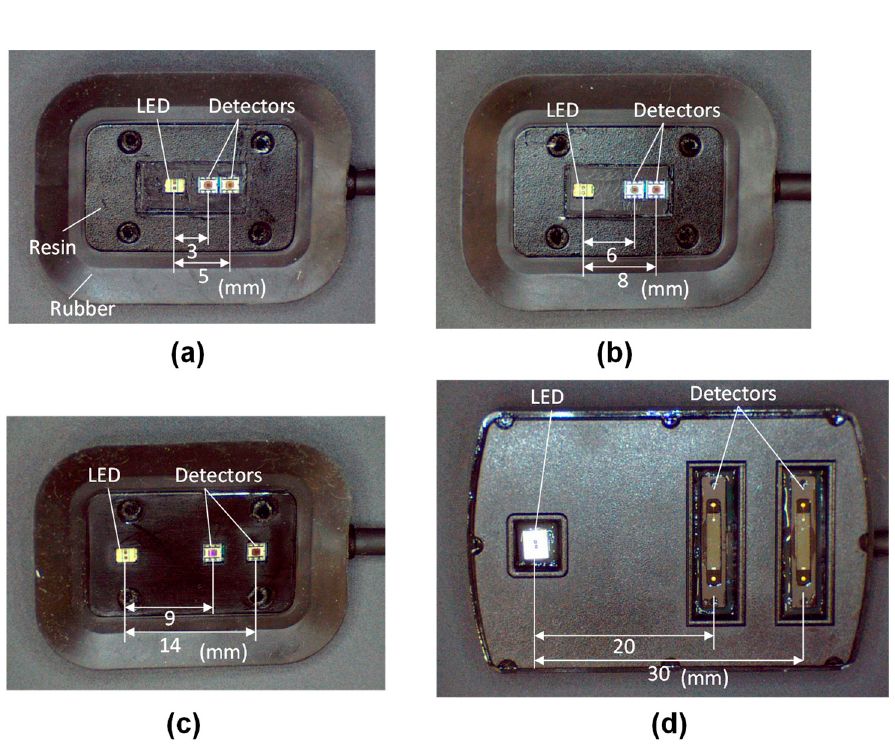
Figure 1. Optical probes with detectors located ( a ) 3 and 5 mm, ( b ) 6 and 8 mm, ( c ) 9 and 14 mm, and ( d ) 20 and 30 mm from the light source (LED).